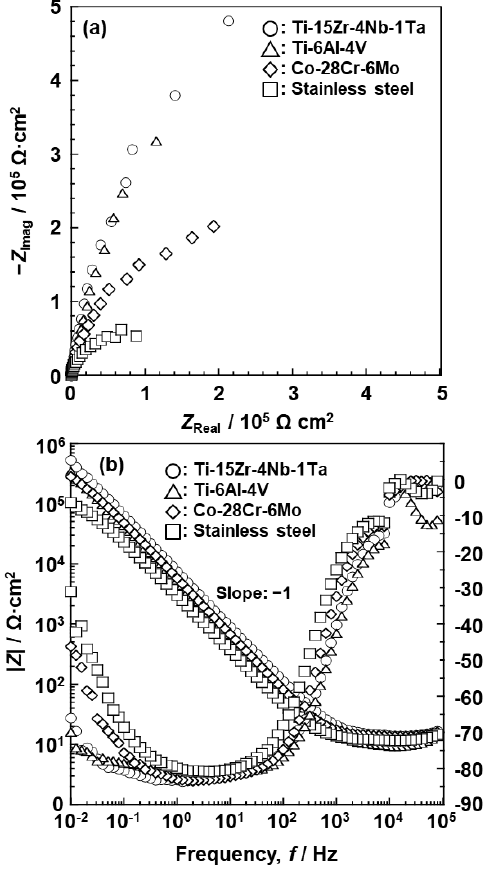
Figure 8. ( a ) Nyquist and ( b ) Bode plots of oxide films on Ti–15Zr–4Nb–1Ta, Ti–6Al–4V, Co–28Cr–6Mo alloy, and high-N stainless steel surfaces after anodic polarization up to 0 V vs. SCE in 0.9% NaCl solution at 37 °C.